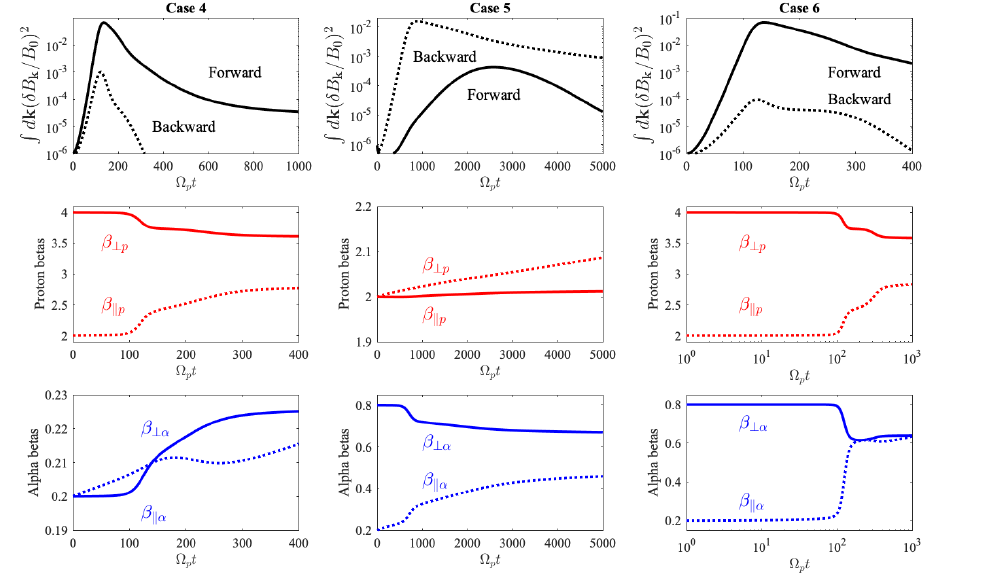
Figure 3. QL dynamical evolution for cases 4–6: the magnetic wave energy density ( top row ), plasma beta parameters for protons ( middle row ), and alpha particles ( bottom row ). See text for details.